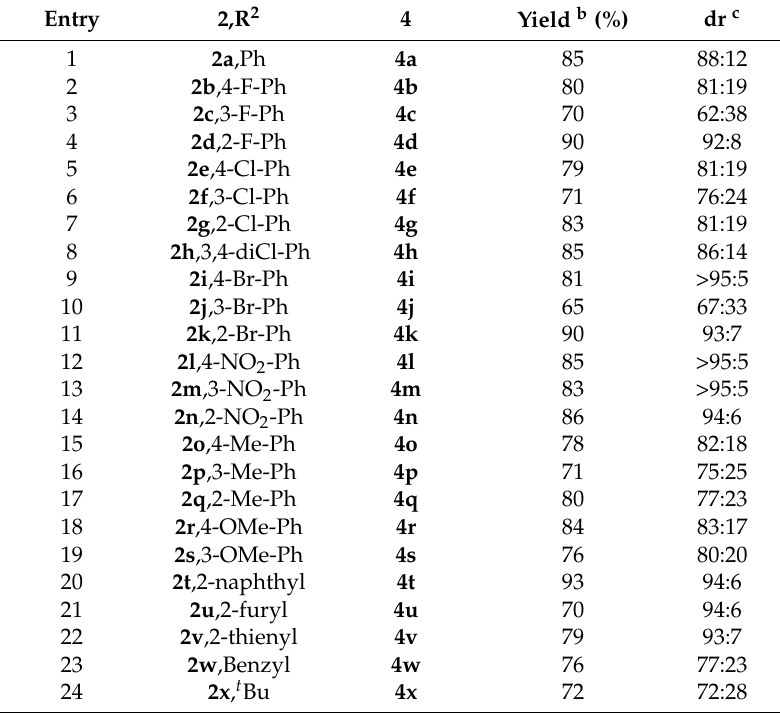
88:12 to 83:17 (Table 2, entry 1 vs. Table 3, entry 6). Unprotected 1d came to the worst results (Table